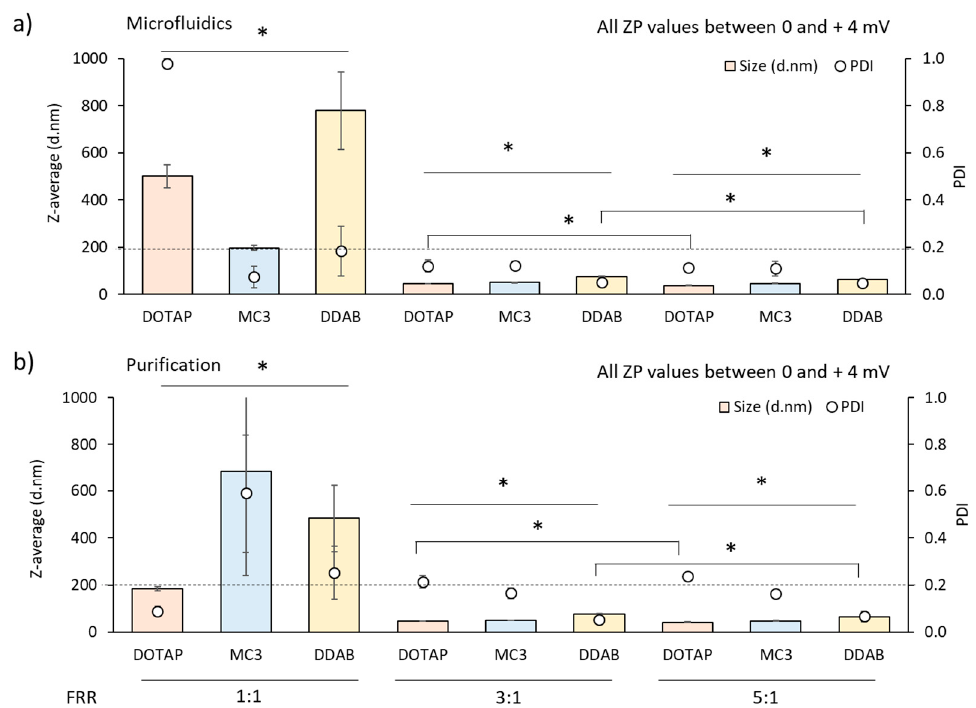
Figure 3. Effect of the flow rate ratio (FRR) on the production of lipid nanoparticles based either on DOTAP (pink), MC3 (blue) or DDAB (yellow) at 20 mL/min TFR using citrate buffer pH 6 100 mM as production buffer. cLNPs were purified via dialysis using TRIS buffer pH 7.4 10 mM whereas iLNPs were dialysed against PBS pH 7.3 10 mM. Particle size (bars) and PDI (open circles) of the LNPs produced using microfluidics ( a ) before and ( b ) after purification via dialysis. Results represent the mean of at least 3 independent batches and the standard deviation is plotted as error bars. ZP (zeta potential). Significant differences are shown as * p < 0.05.